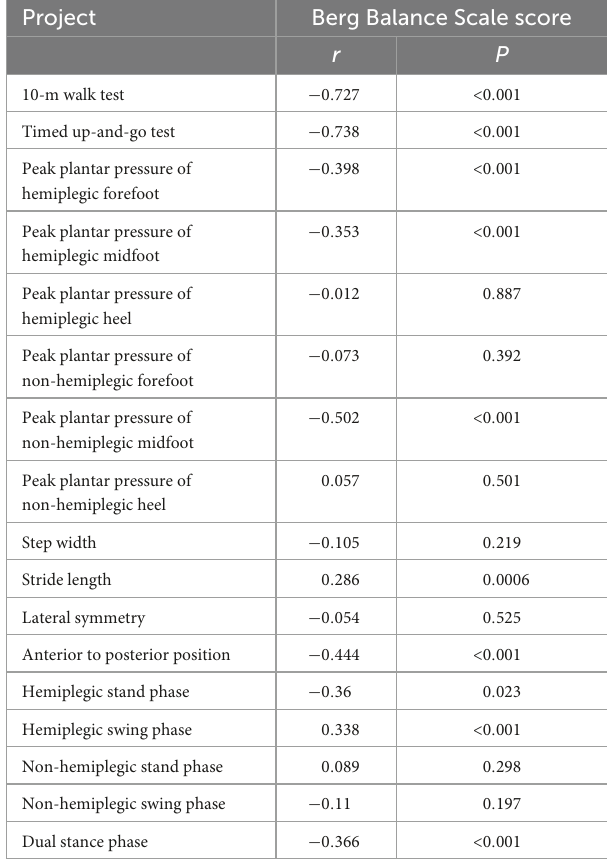
did not analyze the correlation between the balance function and stride length and step width (Koch et al., 2019). This may suggest that the gait characteristics of sensory and non-sensory disorder balance dysfunction are different. Hong et al. (2020) reported that the motor function of the hemiplegic lateral limbs in stroke-affected patients was impaired, and to maintain better gait stability during walking, the patient’s step width was significantly increased and the stride length was reduced. However, the effect of non-sensory balance function on stroke-affected patients was not ruled out.